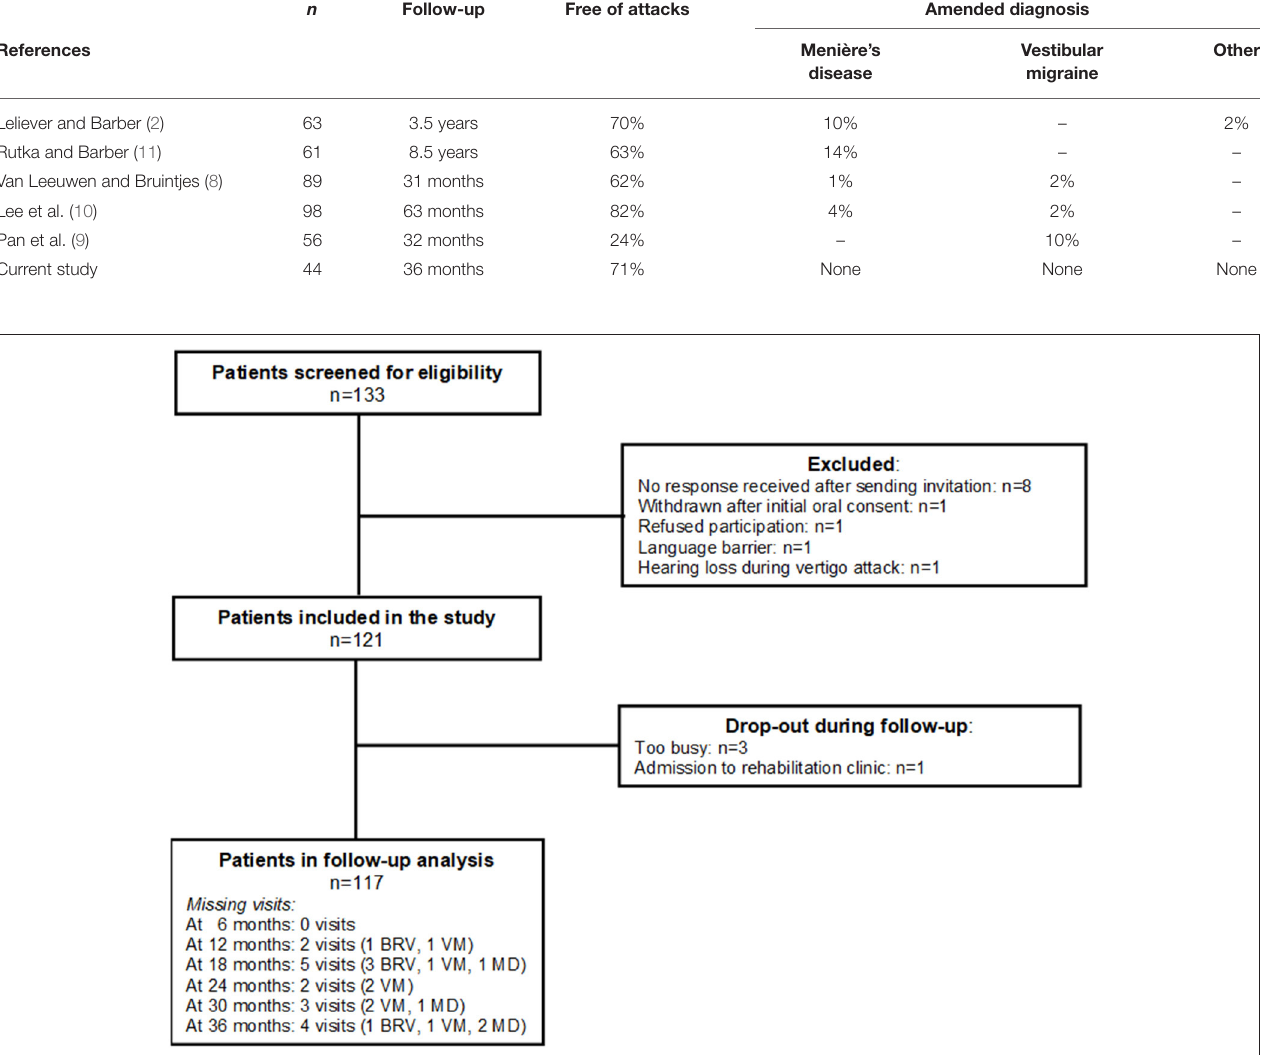
FIGURE 1 | Inclusion and follow-up of the study population. BRV, benign recurrent vertigo; VD, vestibular migraine; MD, Menière’s